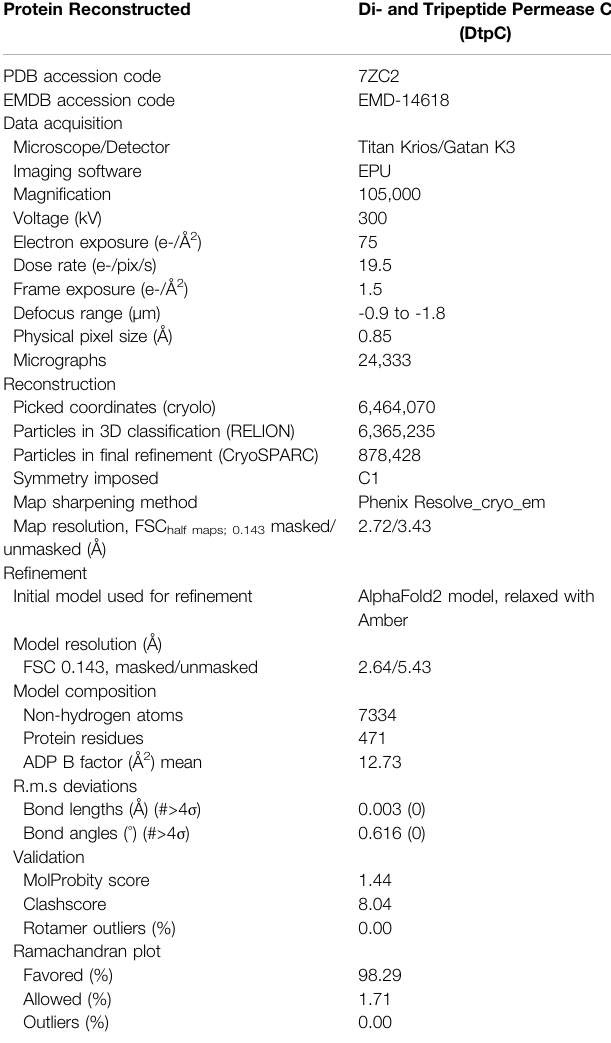
TABLE 1 | Data collection and re fi nement statistics of the deposited DtpC structure. Protein